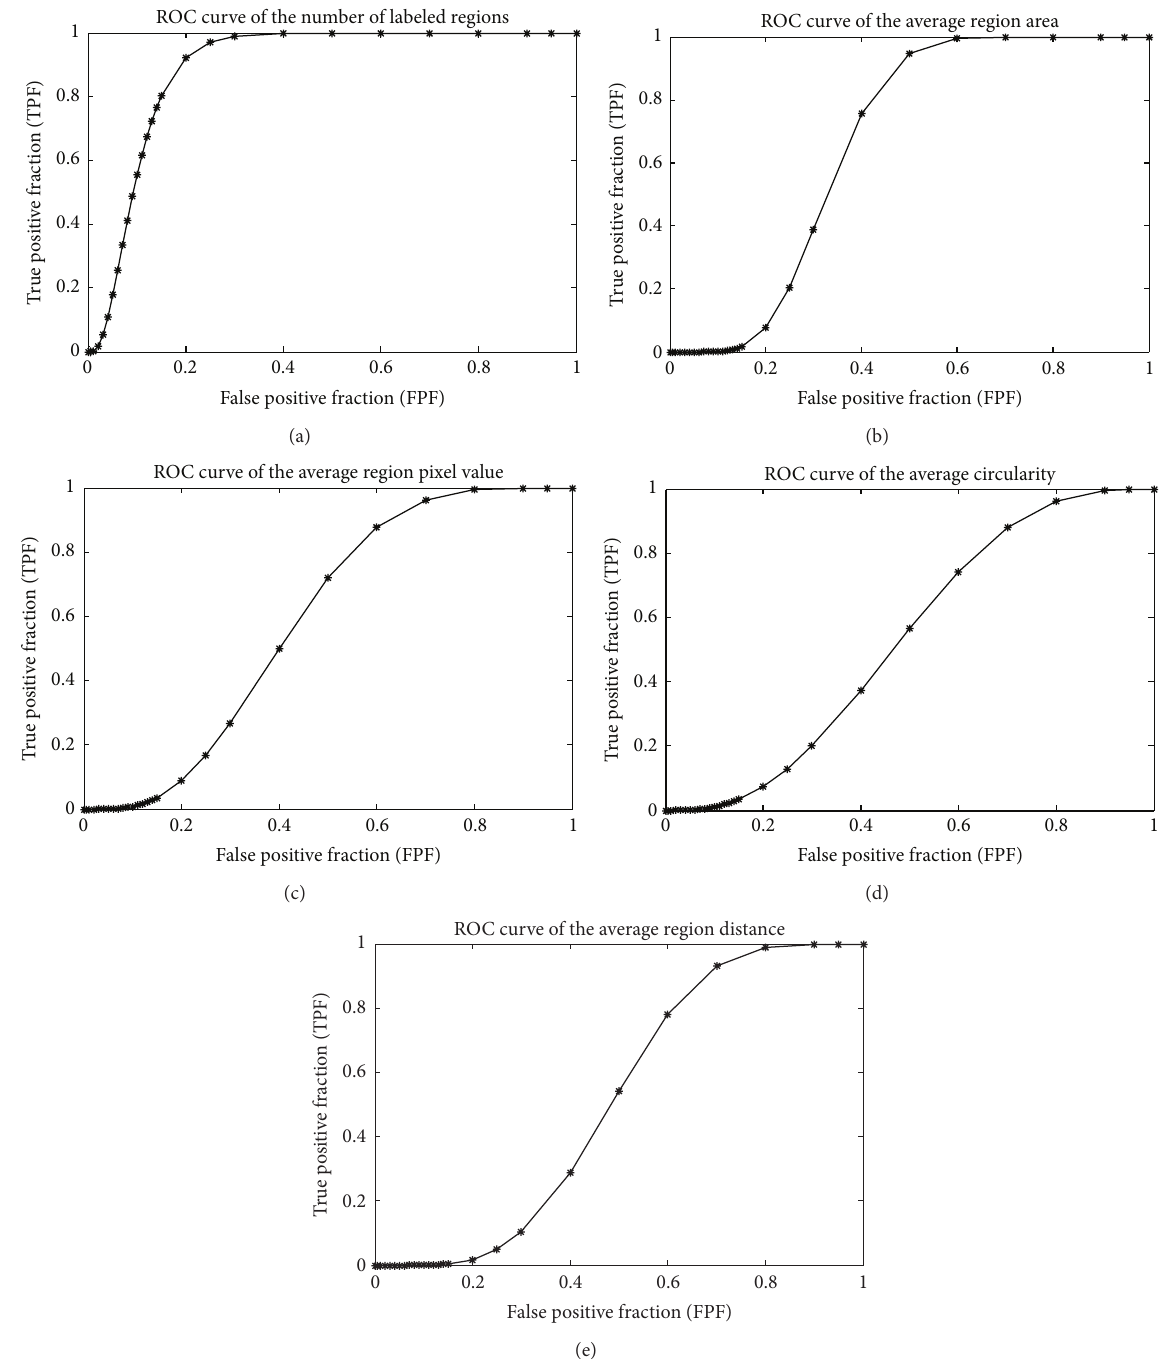
Figure 3: The estimated ROC curve for different extracted features: (a) the number of labeled regions, (b) average region area, (c) average region pixel intensity, (d) average region circularity, and (e) average region distance. Accordingly, the calculated area under curve (AUC) is (a) 0.896 ± 0.023 , (b) 0.666 ± 0.037 , (c) 0.592 ± 0.039 , (d) 0.531 ± 0.040 , and (e) 0.516 ± 0.039 ,